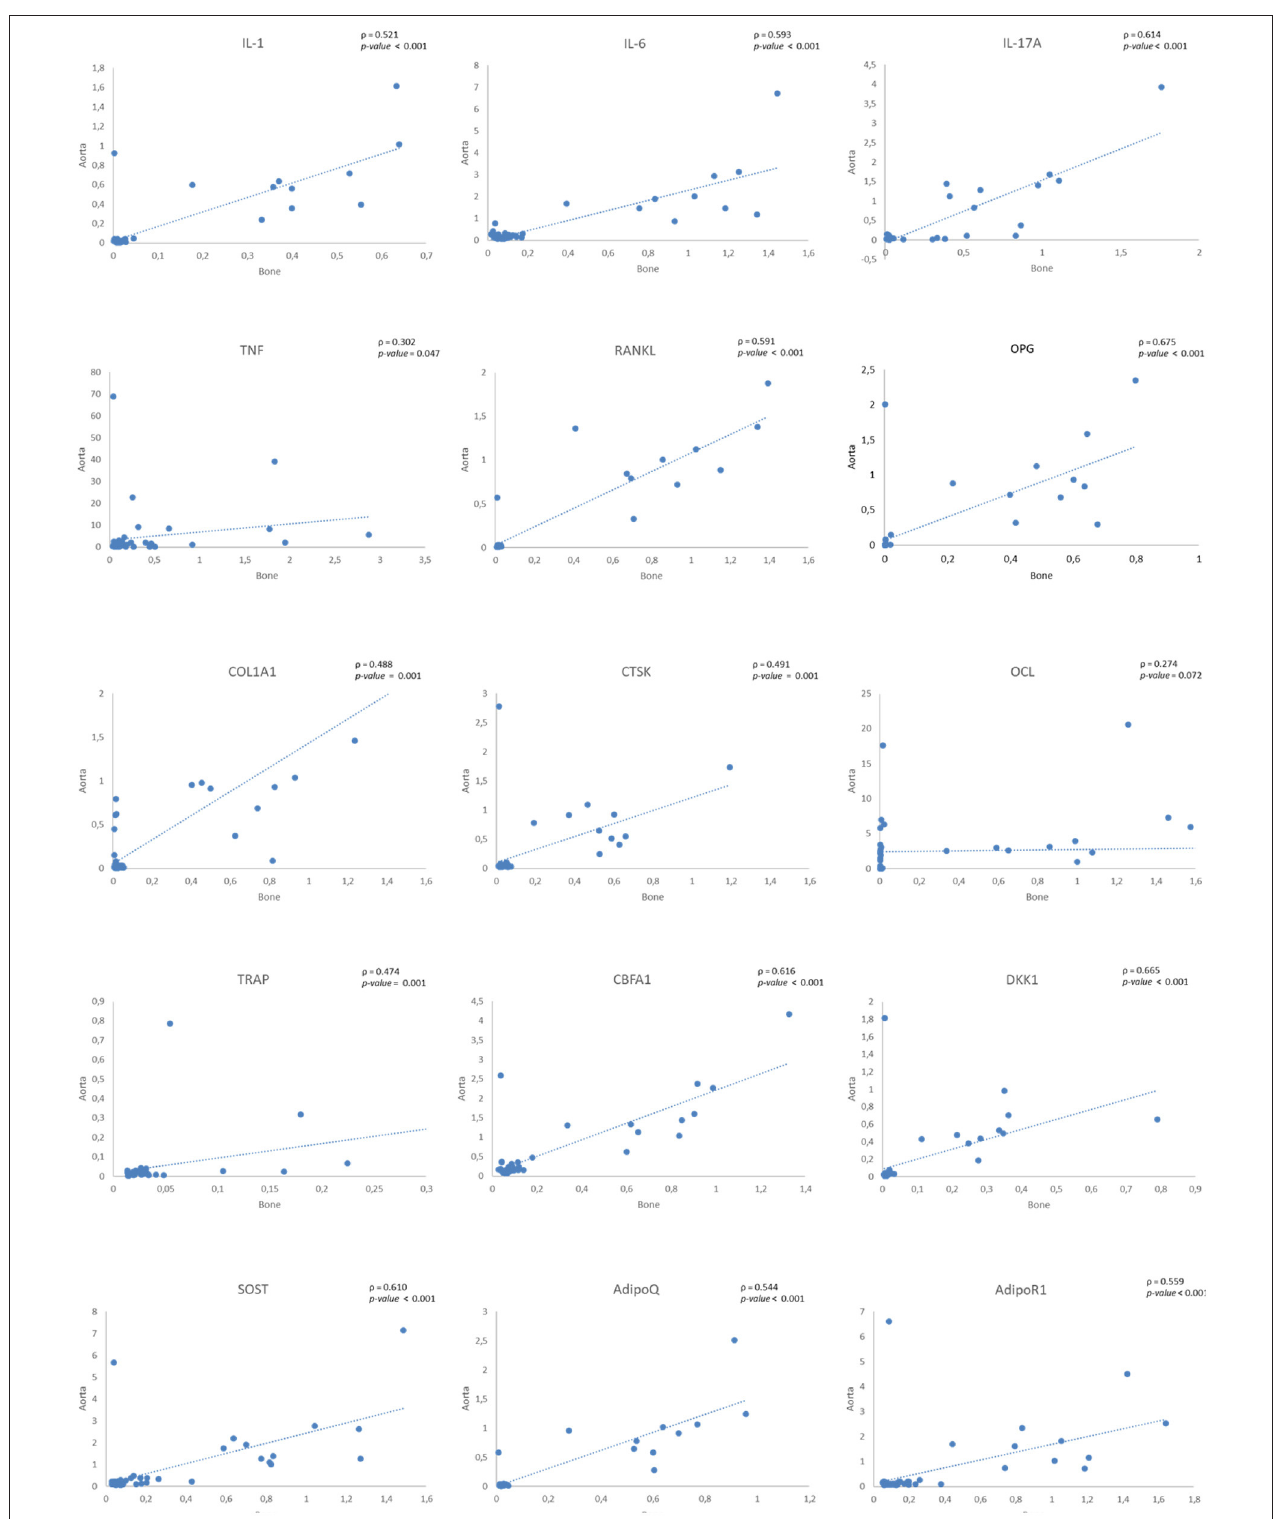
FIGURE 1 | Correlations of gene expression levels between bone and aorta samples. IL, Interleukin; TNF, Tumor necrosis factor; RANKL, Receptor Activator of NF-kB Ligand; OPG, Osteoprotegerin; COL1A1, Collagen type I; CTSK, Cathepsin K; OCL, Osteocalcin; TRAP, Tartrate resistant acid phosphatase; CBFA1, Core-Binding Factor Alpha I; DKK1, Dickkopf-related protein 1; SOST, Sclerostin; AdipoQ, Adiponectin; AdipoR1, Adiponectin receptor 1.